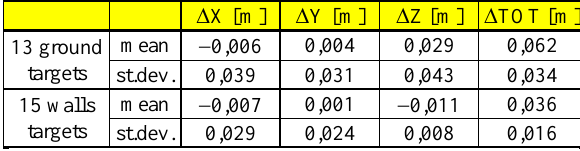
Table 11. Errors on ground/wall targets: images vs topography.